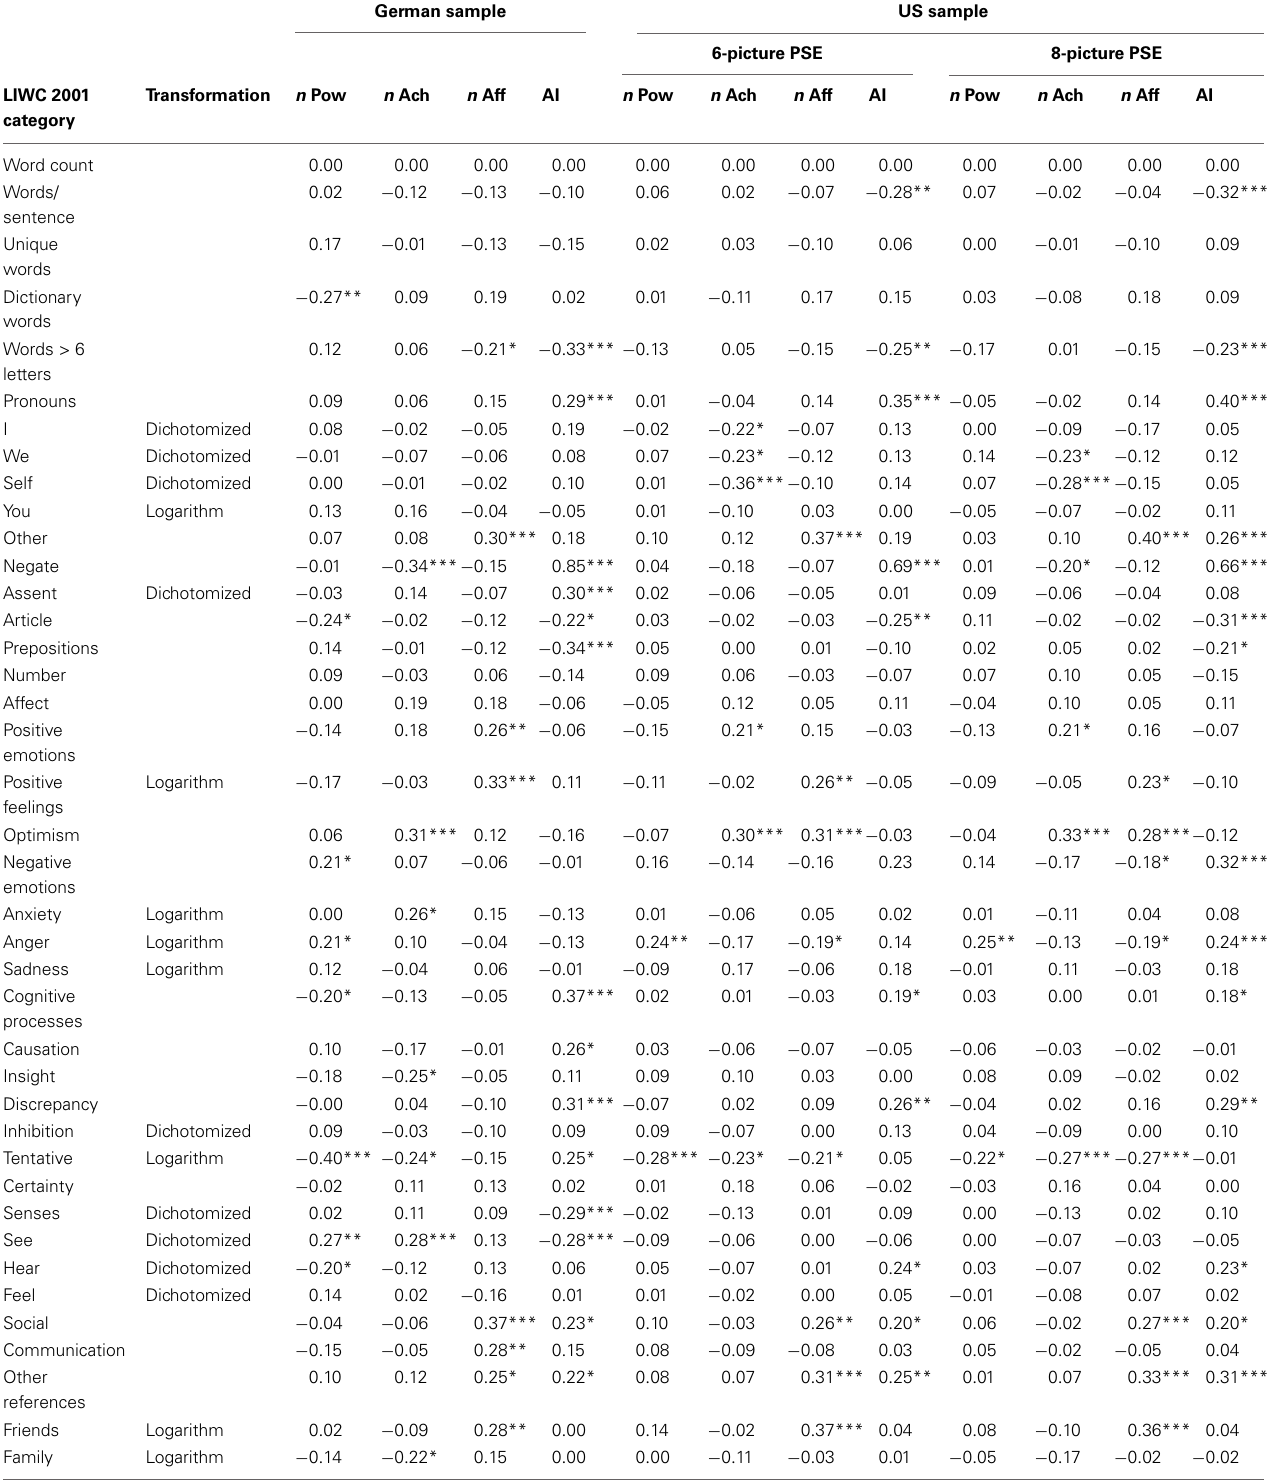
Table 2 | Correlations between content-coded n Power ( n Pow), n Achievement ( n Ach), n Affiliation ( n Aff), and activity inhibition (AI) scores (all residualized for PSE protocol length) and LIWC 2001 categories for German (6-picture PSE) and US samples (6- and 8-picture PSEs) in Study